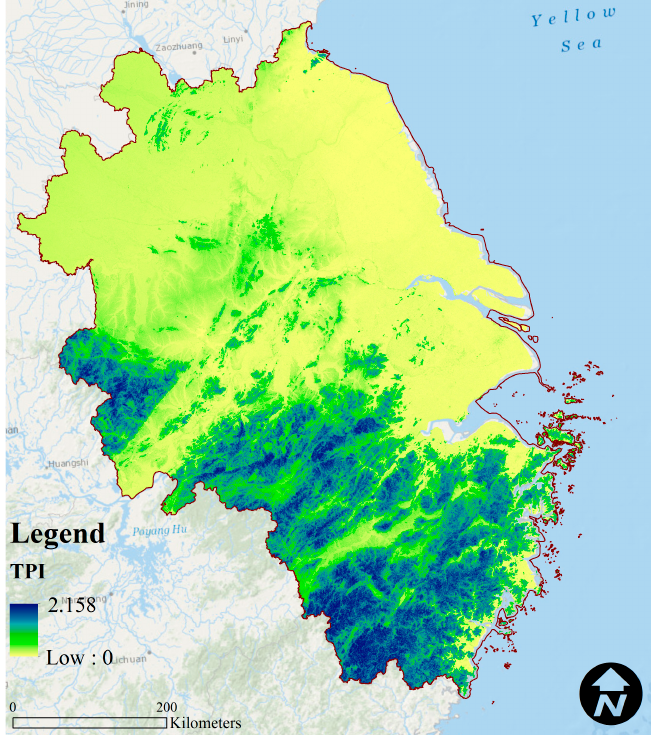
Figure A1. Changes in land use quantity of the Yang tz e River Delta urban agglomeration from 1980 to 2020 (Agr, agriculture; For, forests; Gra, grass; War, Water; Con, Constructed; Bar, bare).